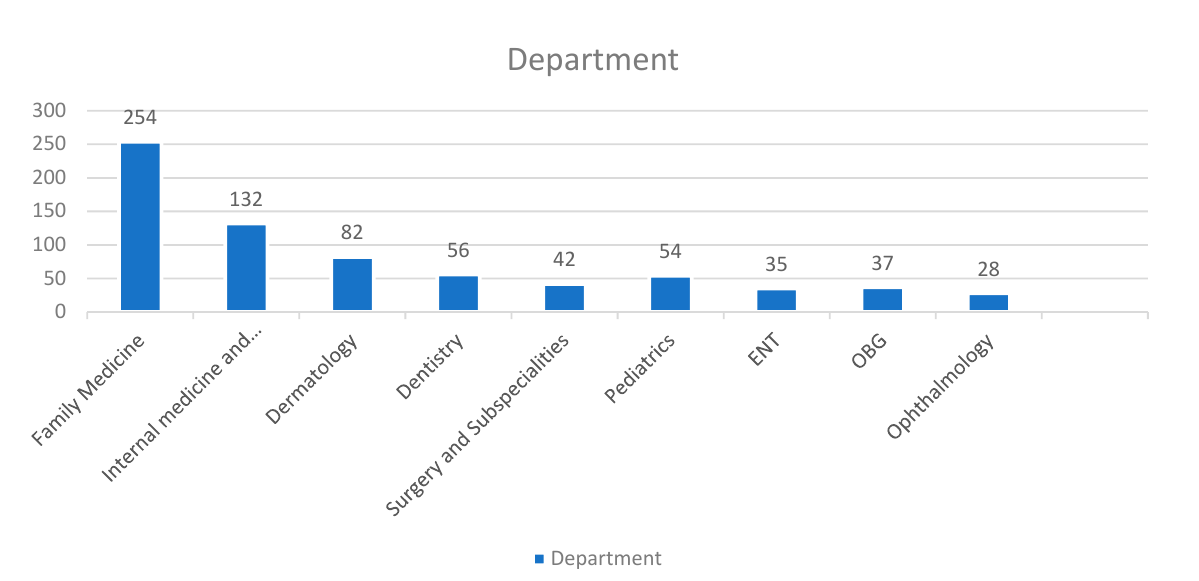
Figure 1. Patients’ distribution according to department. Table 2. Comparison of telemedicine scores with patients’ background